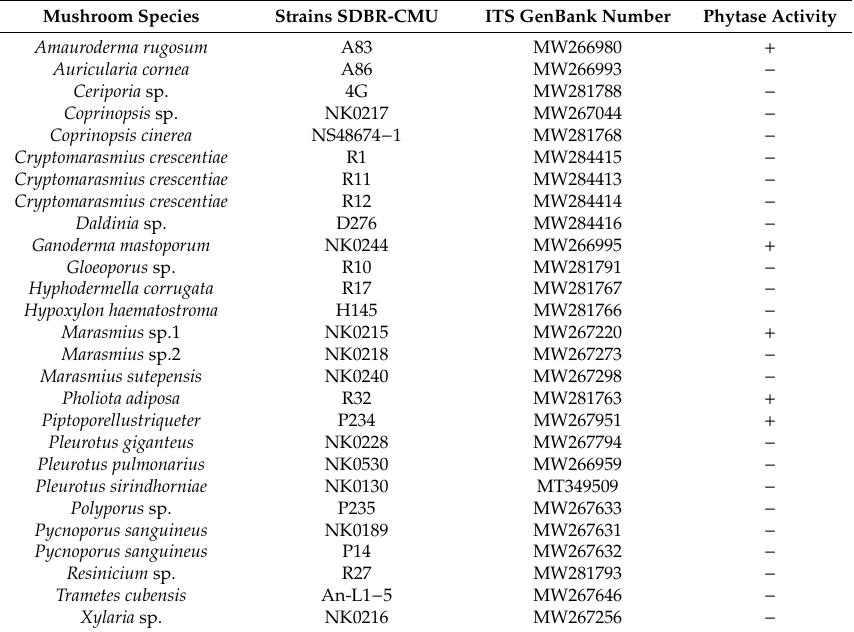
Table 3. The list of mushroom strains screened for phytase activity in this study.